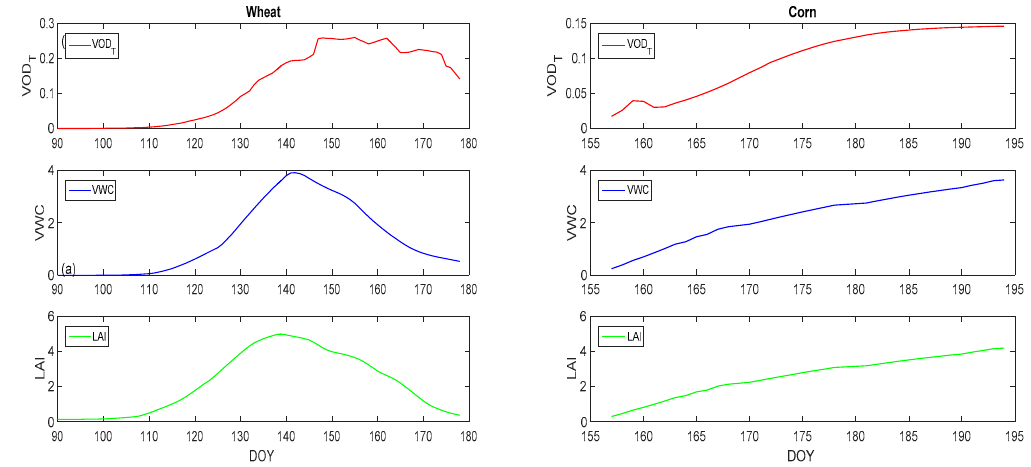
Figure 9. Trend of VOD T compared to measured VWC and leaf area index (LAI) for wheat and corn ( left: wheat, right: corn) .